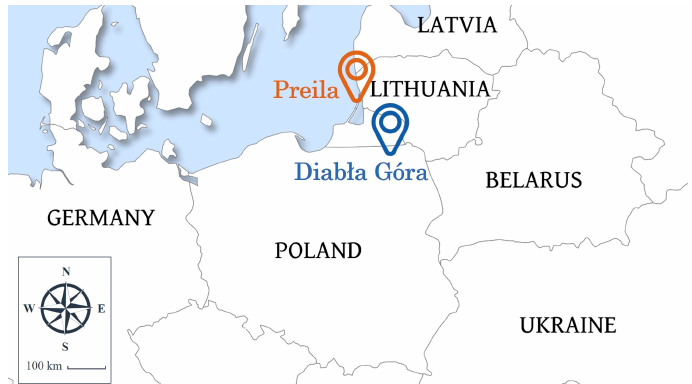
Figure 1. Map of the region showing the locations of the Diab ł a Góra measurement site together with the Preila site used for comparison (freeworldmaps.net).